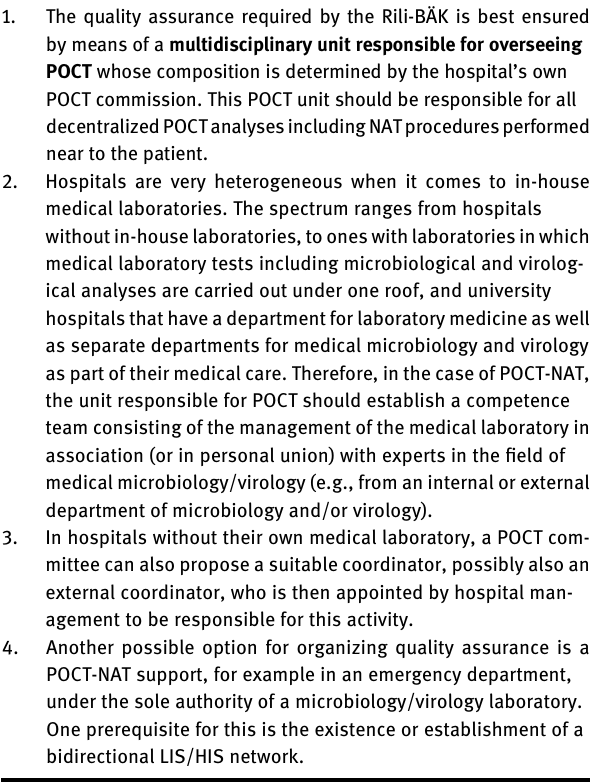
Table  : Recommendations for the appropriate use of near-patient nucleic acid testing